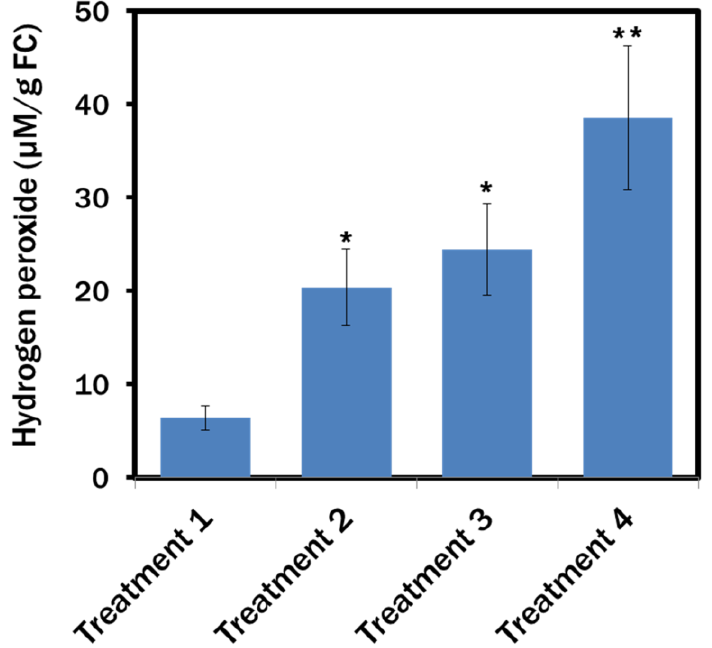
Figure 6. Hydrogen peroxide content in the Chlamydomonas reinhardtii cells of different treatments. Treatment 1: modified Woods Hole (MBL) medium; Treatment 2: MBL, (−) N 2 ; Treatment 3: